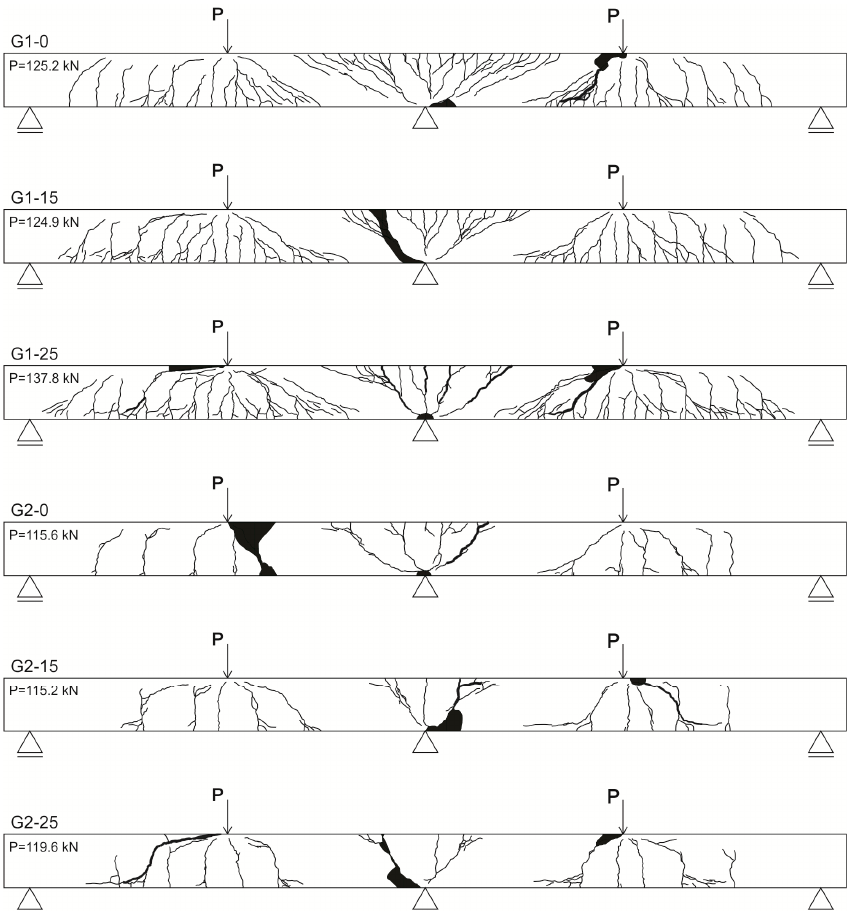
Figure 4. Crack patterns of experimental beams at failure (P—load at failure).